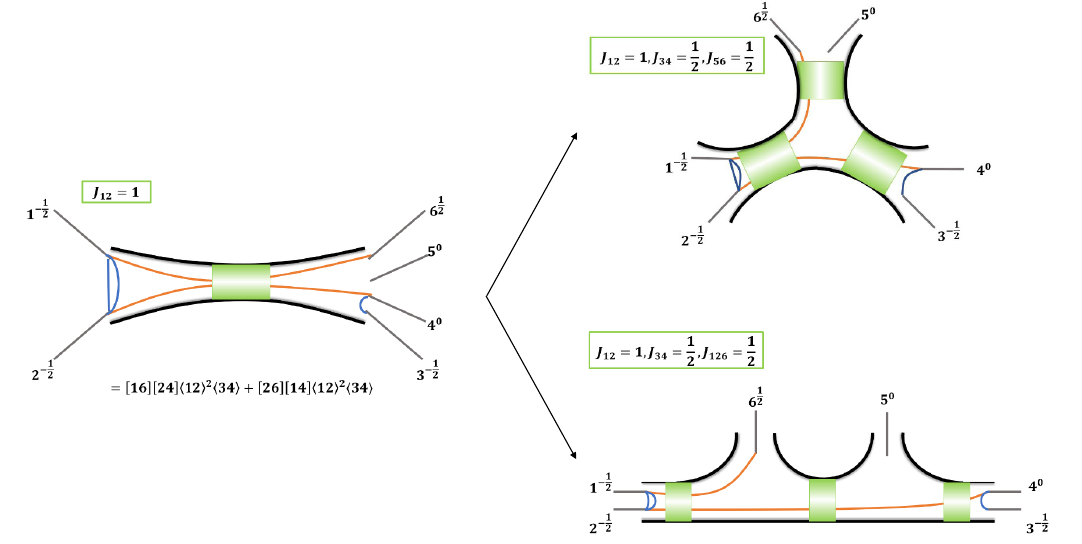
Figure 4 . An example of 6-particle 2-partite and 3-partite partial wave basis constructed by the spinor bridge rule. We show that there can be different subdivisions of the partition { 12 | 3456 }